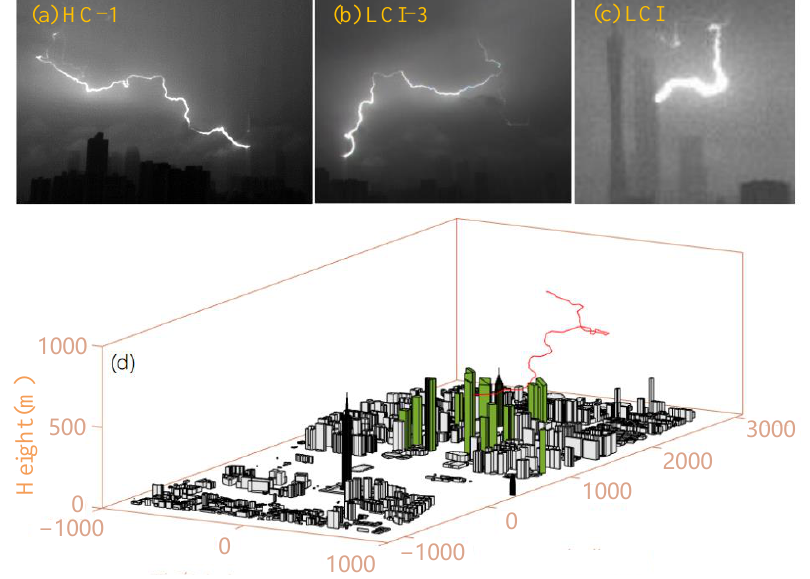
Figure 10. ( a – c ) Optical images ( d ) The 3D channel of a +CG lightning return stroke striking the side of the CTF Finance Center.